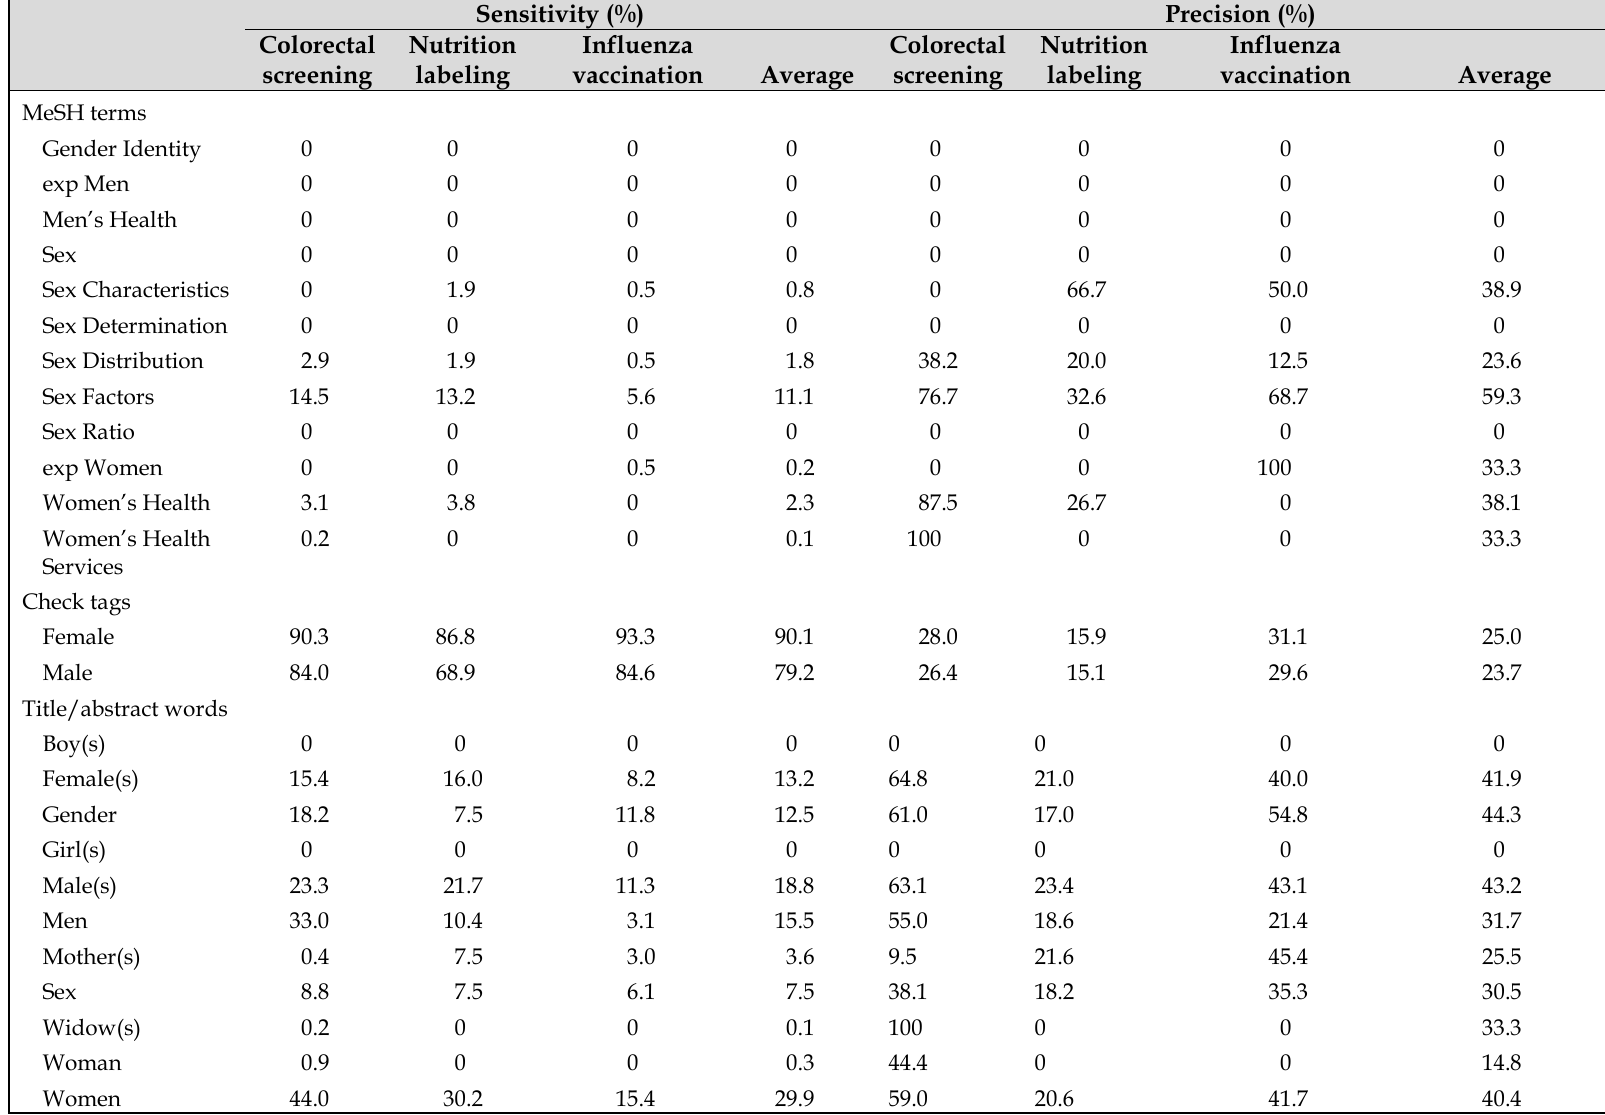
Table 4 Search filter performance: all years